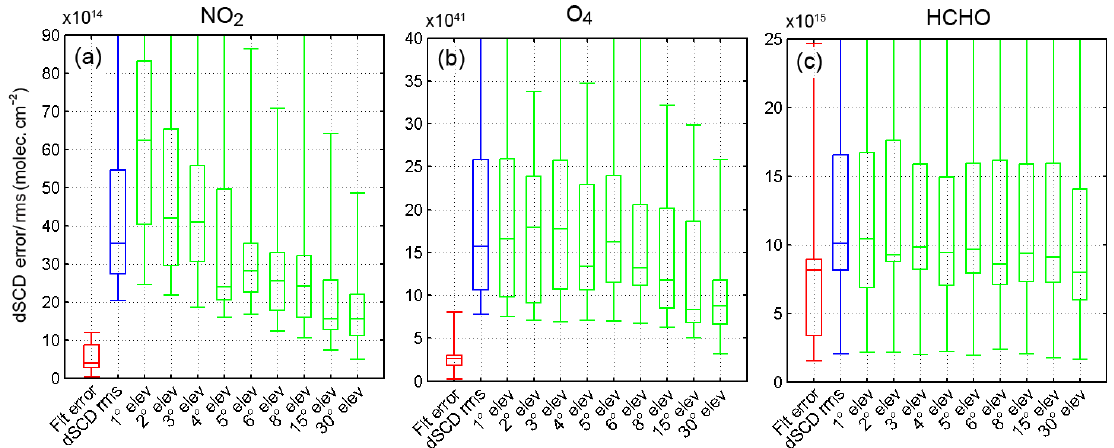
Figure 14. (a) Box-and-whisker plot of the 1 σ dSCD fit error (red), the regression rms for all elevation angles (blue) and rms from dSCD regression analyses sorted as a function of the elevation angle (green) for NO 2 in the visible wavelength range. (b) Same as (a) but for O 4 (visible). (c) Same as (a) but for